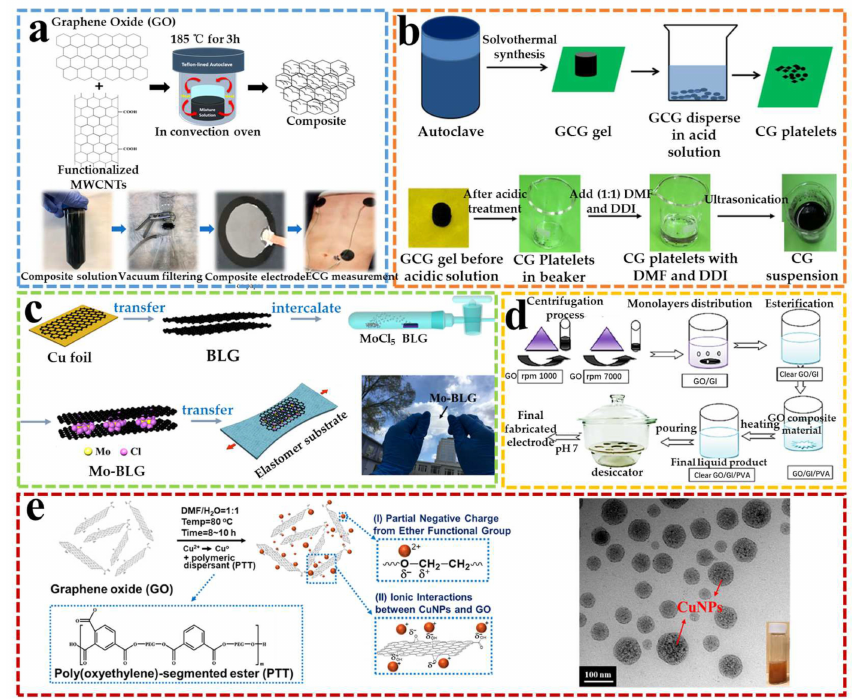
Figure 4. Modified-graphene based electrodes. ( a ) The schematic illustration of the preparation processes (above) and photos (below) of chemically-modified graphene–CNT ECG electrodes. Reprinted with permission from Ref. [68]. Copyright 2019, MDPI. ( b ) Preparation processes of the environmentally friendly, chemically modified graphene ECG electrode. Reprinted with permission from Ref. [69]. Copyright 2017, IOPscience. ( c ) Fabrication processes and photo of the intercalation doping graphene ECG electrode. Reprinted with permission from Ref. [71]. Copyright 2020, American Chemical Society. ( d ) Preparation of the glycerol-modified, graphene-oxide ECG electrode. Reprinted with permission from Ref. [72]. Copyright 2022, IOPscience. ( e ) Fabrication processes of hybrid copper nanoparticle–graphene oxide and its photos. Reprinted with permission from Ref. [74]. Copyright 2022,